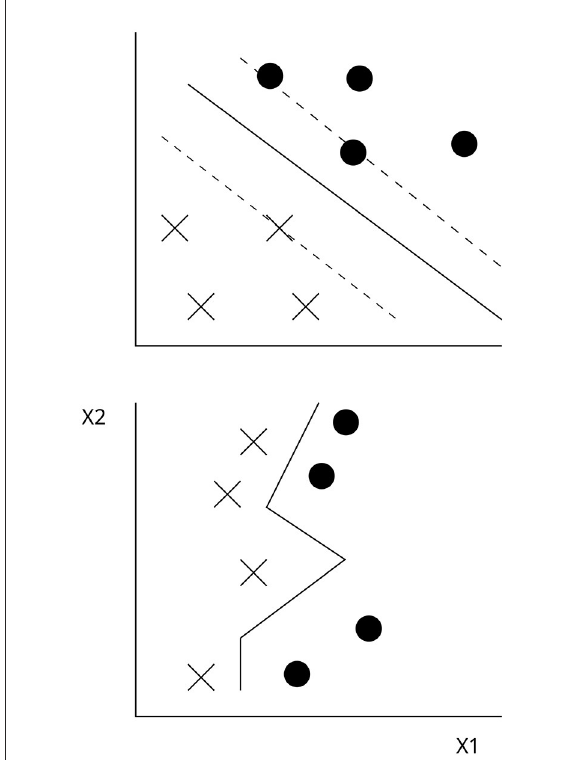
FIGURE1 Illustration of SVMs and the linear separation of the categories, dots and crosses, (upper) and generalizability (lower) in a binary